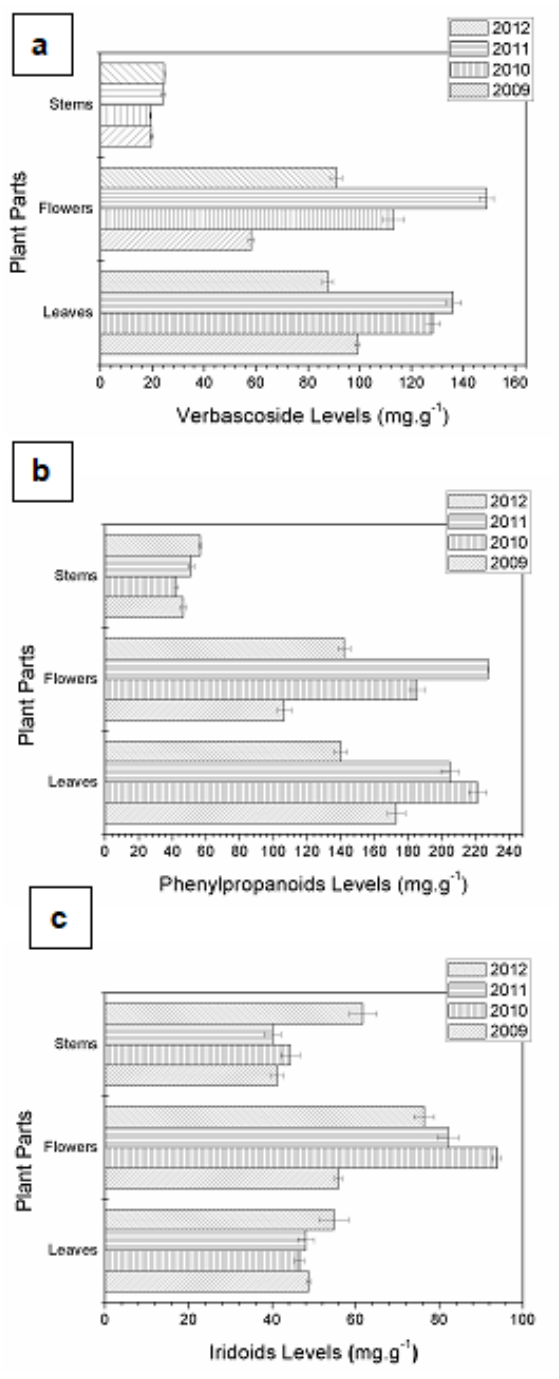
Figure 4. Annual variation of levels of Verbascoside (a), Total Phenylpropanoids (b), Iridoids (c) in aerial parts of Verbena